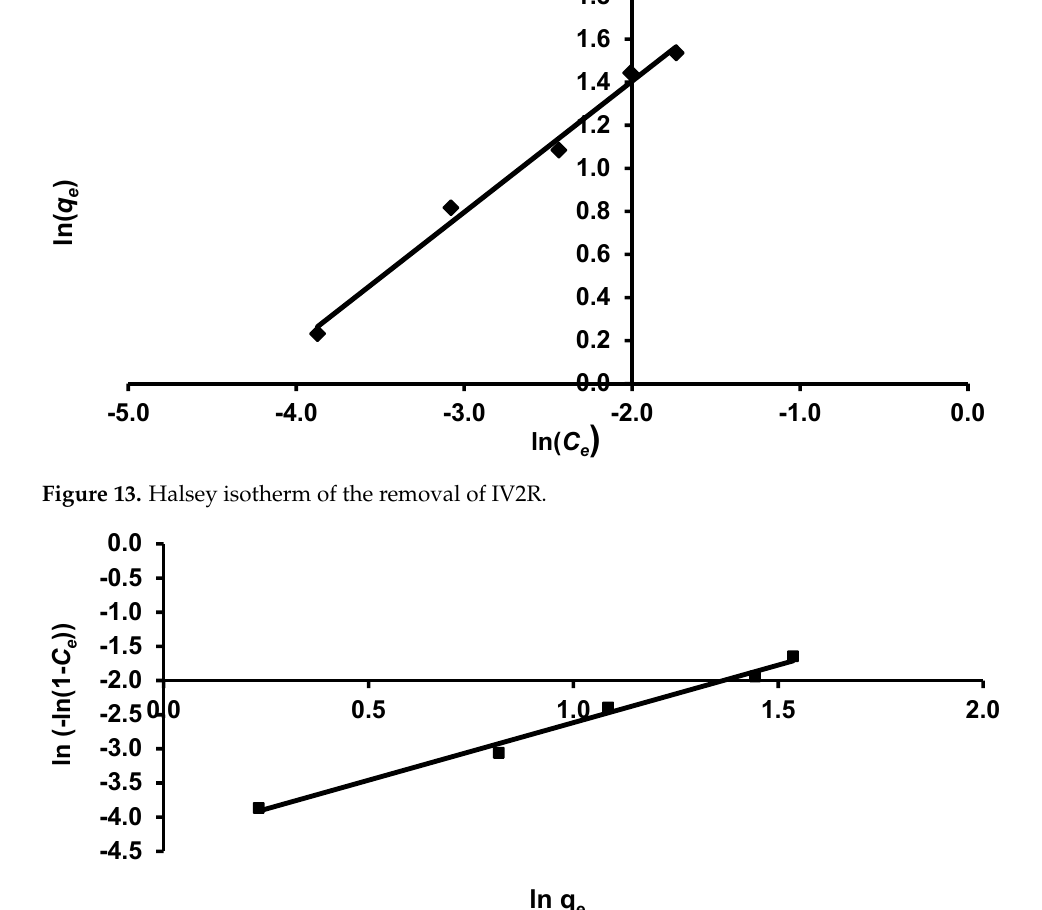
Figure 14. Linear Henderson isotherm of the removal of IV2R.